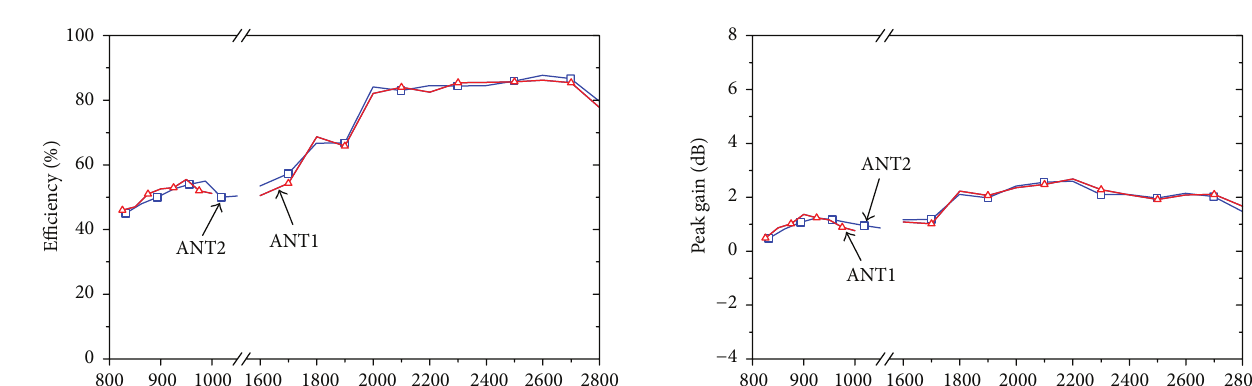
Figure 6: Measured 2D radiation patterns of the antenna element at different frequencies. (a) 900 MHz (ANT1); (b) 2500 MHz (ANT2) (— 𝐸 𝜃 ;--- 𝐸 𝜑 , unit: dBi).